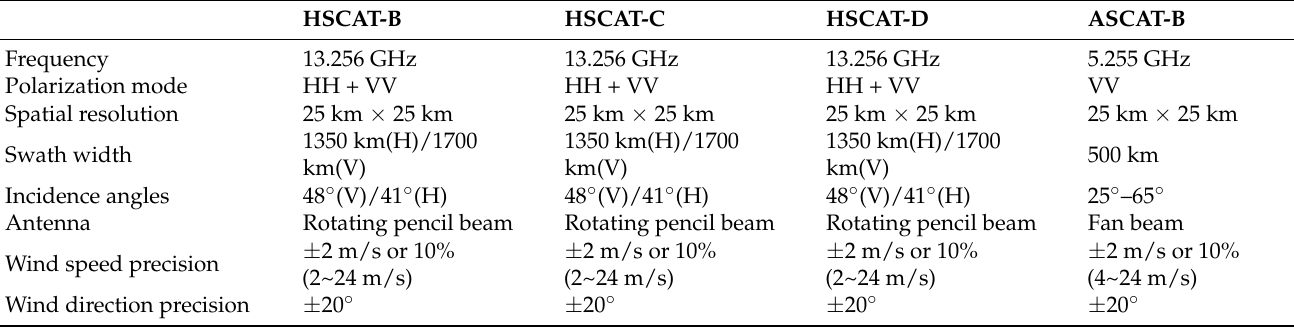
Table 1. Parameters of HSCAT-B, HSCAT-C, HSCAT-D, and